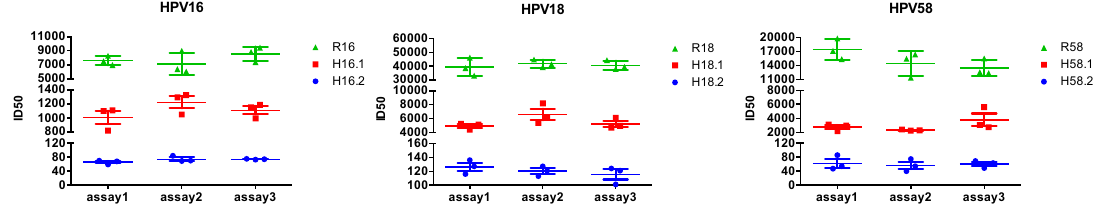
Figure 6. Reproducibility of the triple-color PBNA. R16, R18, and R58 were rabbit serum samples immunized with corresponding mono-valent HPV vaccines. H16.1, H16.2, H18.1, H18.2, H58.1, and H58.2 were serum samples from naturally infected individuals.